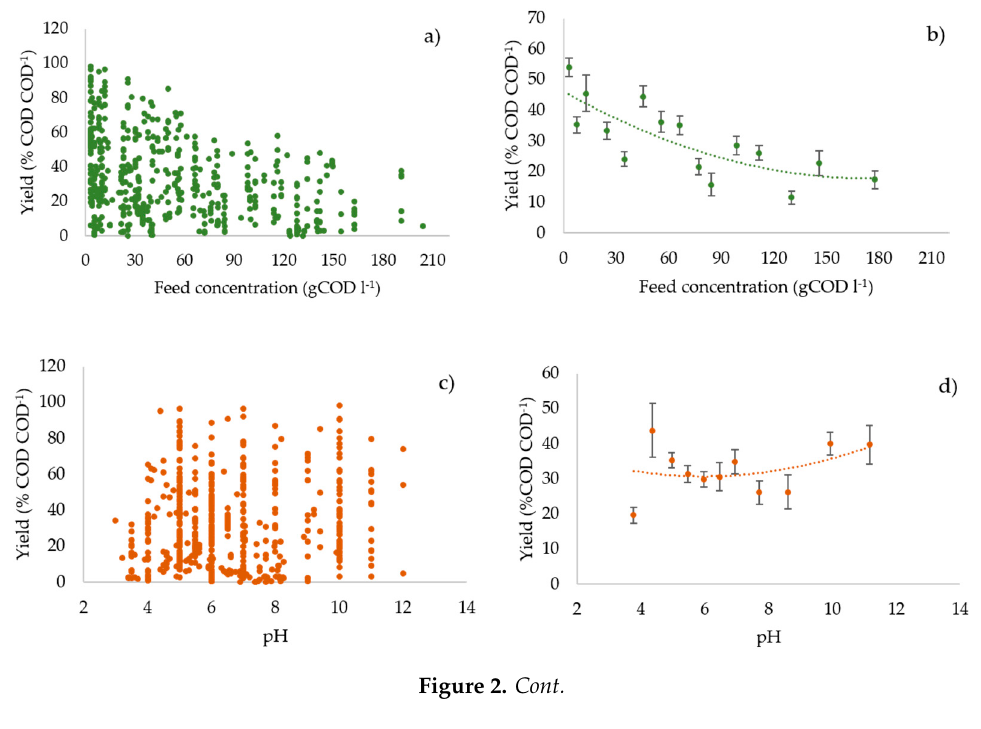
Figure 1. Relationships between product concentration and operating parameters. ( a , c , e , g ) All the considered experiments. ( b , d , f , h ) Average values of experiments in each narrow range (width maximum 20%) of the operating parameters (error bars indicate the standard error) with second grade polynomial curve. The polynomial curve is only used to visualise the general trend, without any statistical significance.